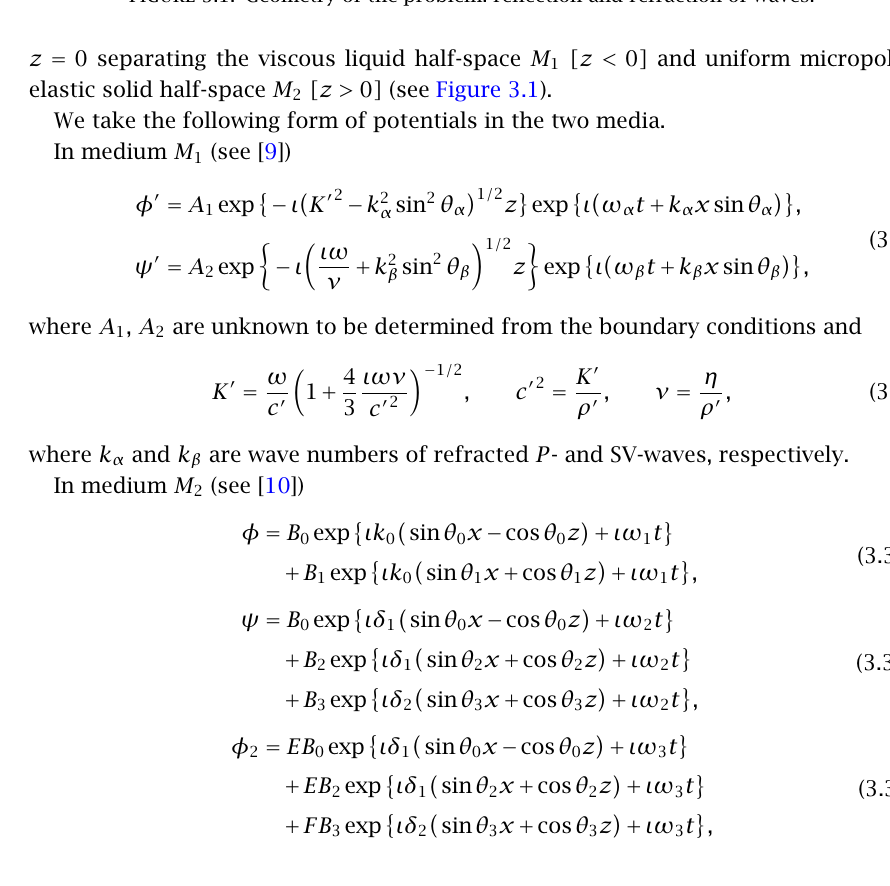
Figure 3.1 . Geometry of the problem: reflection and refraction of